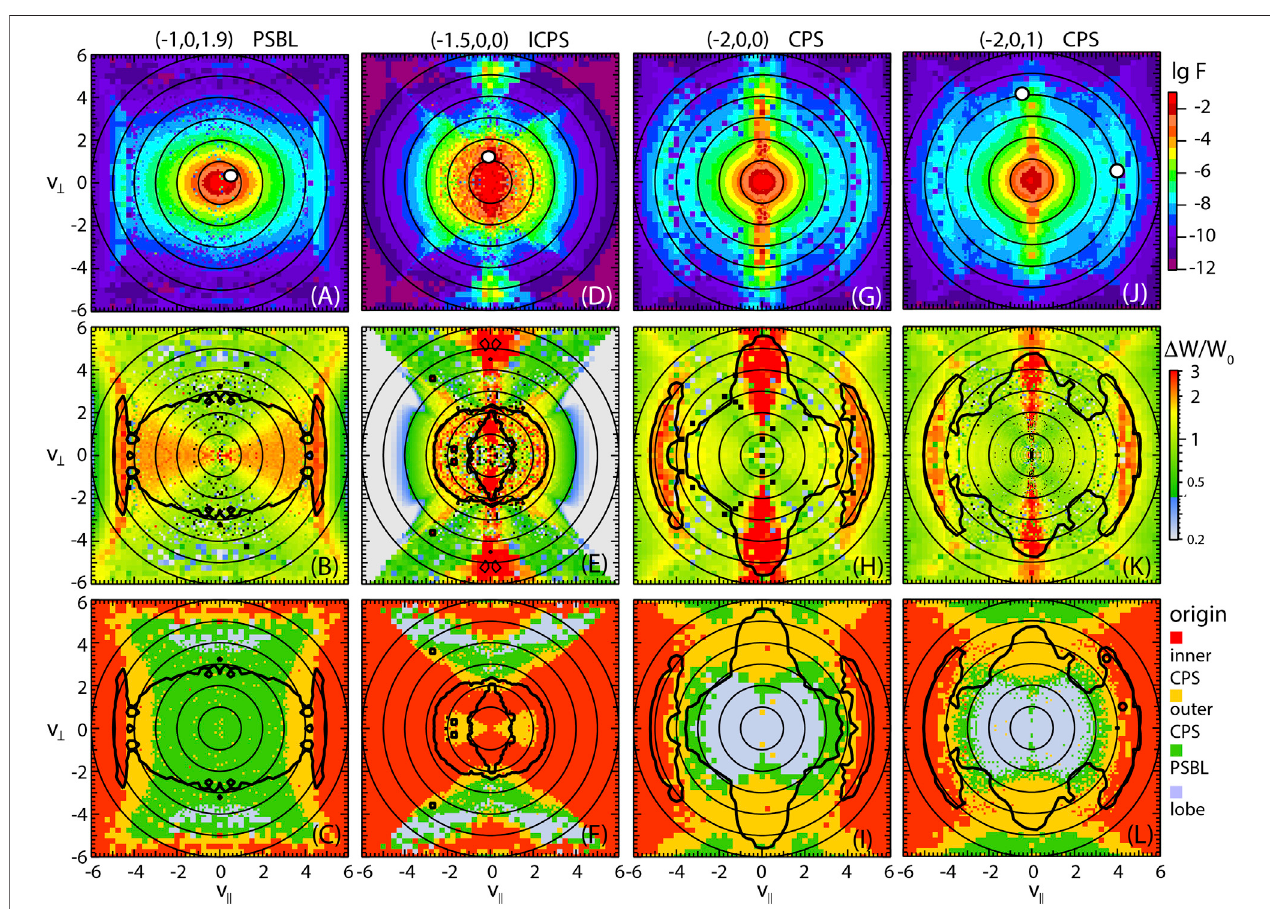
FIGURE4| Electronvelocitydistributionsatchosenlocationfor t =132: (toprow,a,d,g,j) phasespacedensity, (secondrow,b,e,h,k) relativeenergygain,and (third row, c, f, i, l) origin of particles contributing to the phase space density. For the chosen normalization, the velocity unit is given by (3) as 42,850 km/s. The heavy black contours indicate the regions of enhanced F (top row) and the white dots in the top panels show fi nal velocities used to illustrate characteristic orbits in Section 5 .